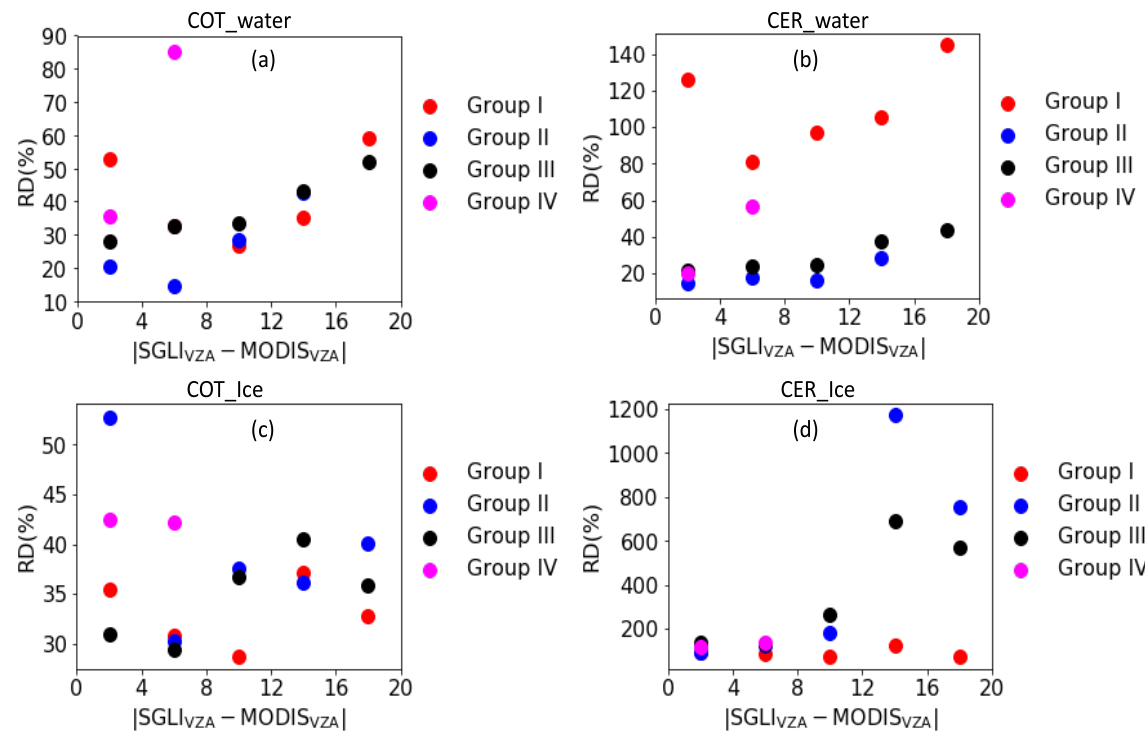
Figure 7. RD values as functions of absolute VZA difference between SGLI and MODIS sensors for ( a ) COT and ( b ) CER of water clouds and ( c ) COT and ( d ) CER of ice clouds.